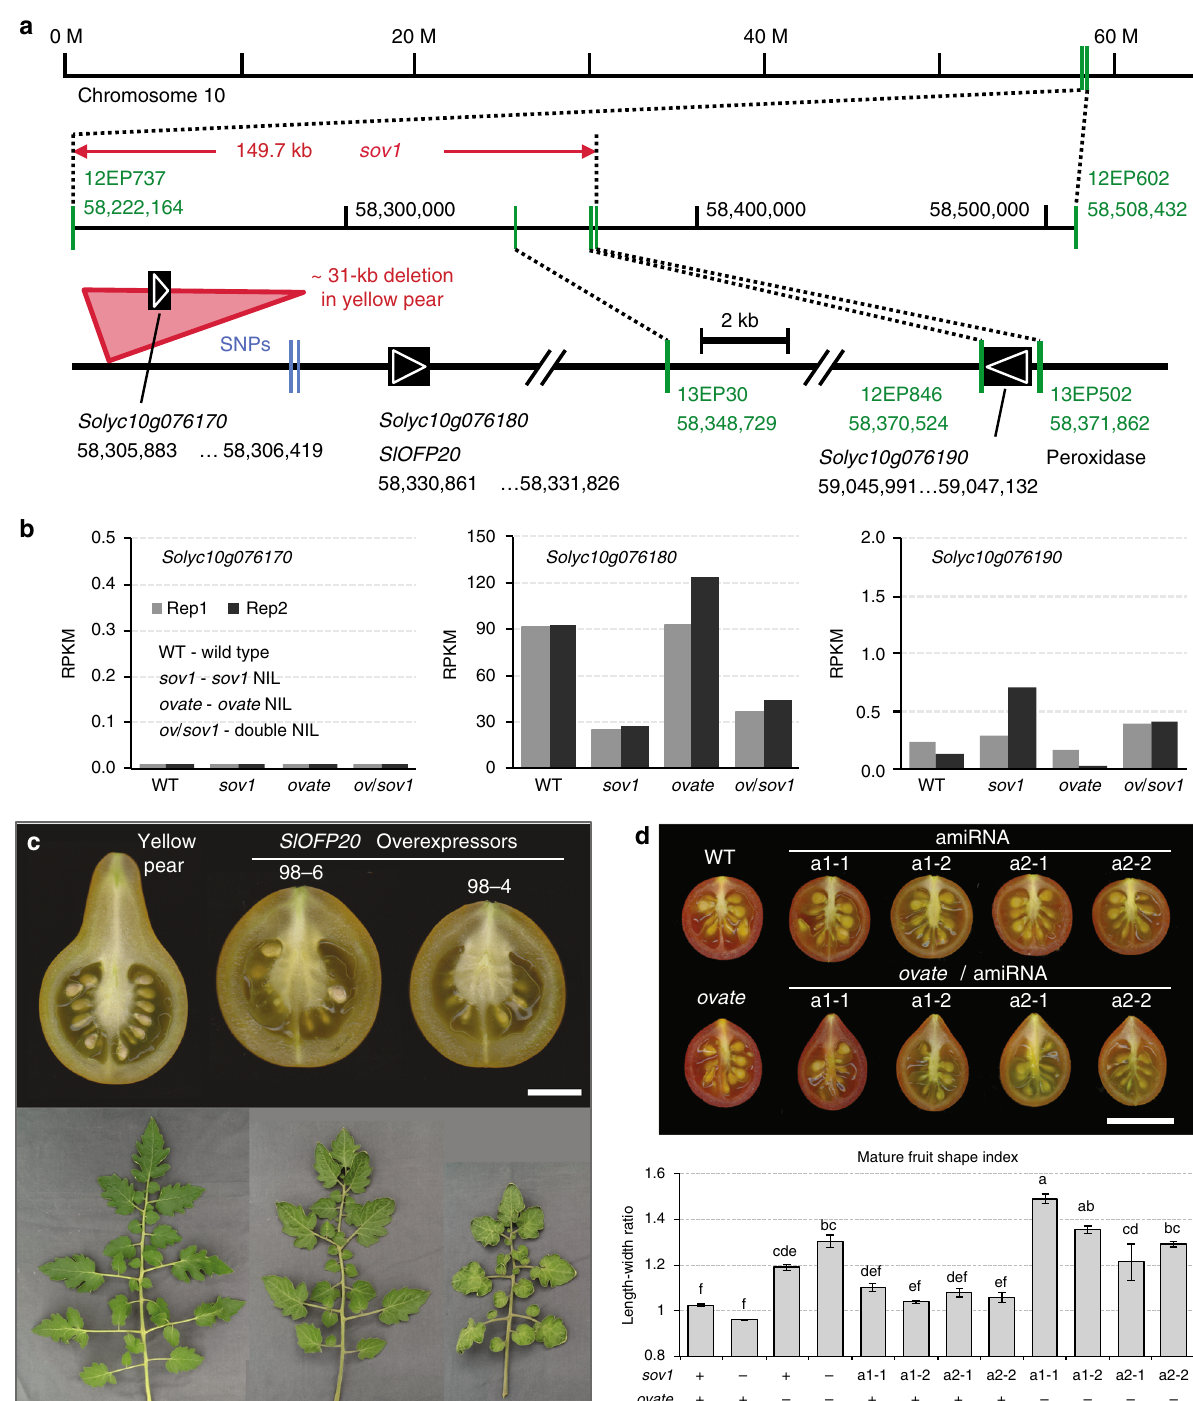
Fig. 1 Map-based cloning of SlOFP20 . a The 149.7-kb sov1 locus on tomato chromosome 10. Markers are indicated in green. The physical positions in base pairs are labeled beneath markers and genes. b Expression levels of the three genes within the sov1 locus in anthesis-stage tomato fl owers from the ovate and sov1 NILs. RPKM, reads per kilobase of transcript per million mapped reads. c Effect of overexpression of SlOFP20 on fruits and leaves of Yellow Pear in two independent T 0 transgenic lines. d Effect of down regulation of SlOFP20 . The lines are BC 1 F 2 from four independently transformed lines expressing two different arti fi cial microRNAs (amiRNAs, a1 and a2) targeting SlOFP20 . The error bars and letters in the graph indicate the standard errors among four plants and signi fi cant differences in fruit shape index evaluated by Tukey ’ s test ( α < 0.05), respectively. + , wild type allele; -, mutant allele. The white and black bars represent 1 cm and 5 cm,